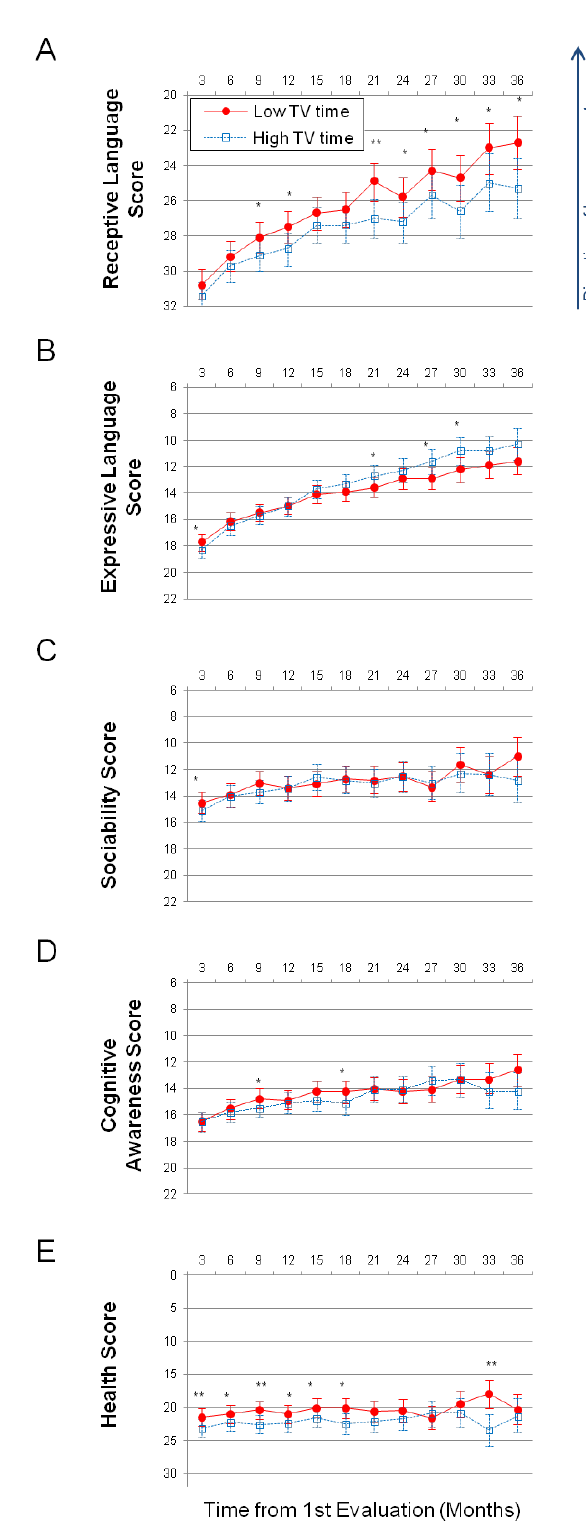
Figure 1. Longitudinal plots of subscale scores LS Means. Horizontal axis shows months from the 1st evaluation (0 to 36 months). Error bars show the 95% confidence interval. To facilitate comparison between subscales, all vertical axes ranges have been normalized to show 40% of their corresponding subscale’s maximum available score. A lower score indicates symptom improvement. P-value is marked: ** p < 0.001; * p < 0.05. ( A ) Receptive language score. ( B ) Expressive language score. ( C ) Sociability score. ( D ) Cognitive awareness score. ( E ) Health